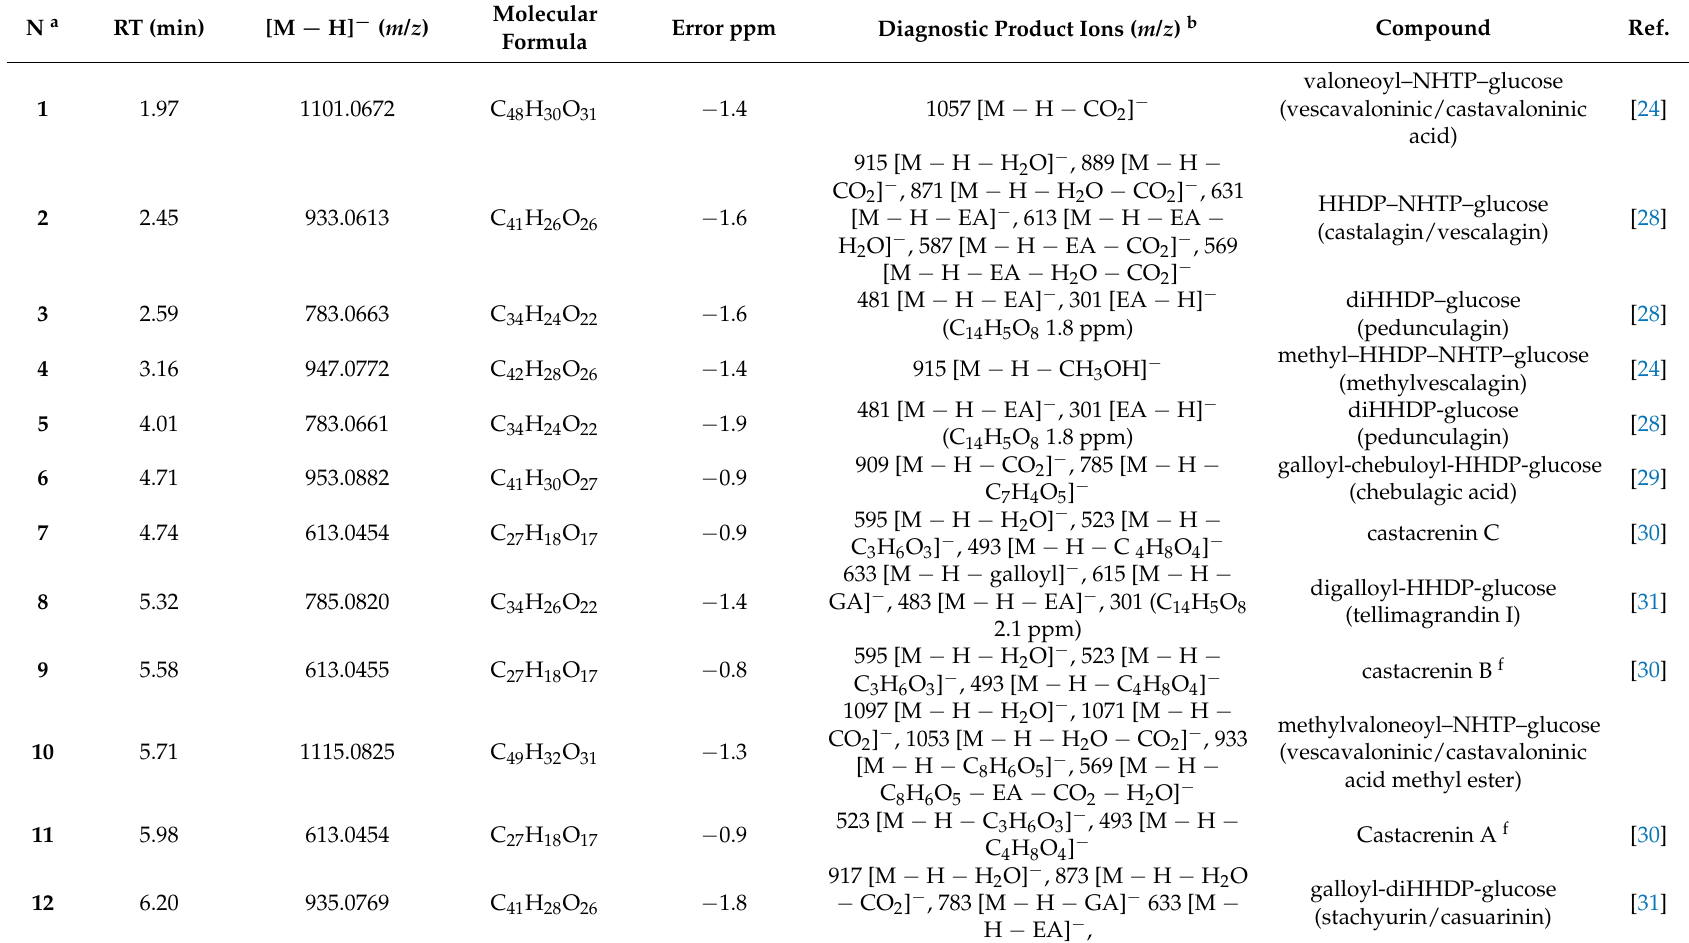
Table 2. UHPLC-HRMS data of compounds detected in CSB